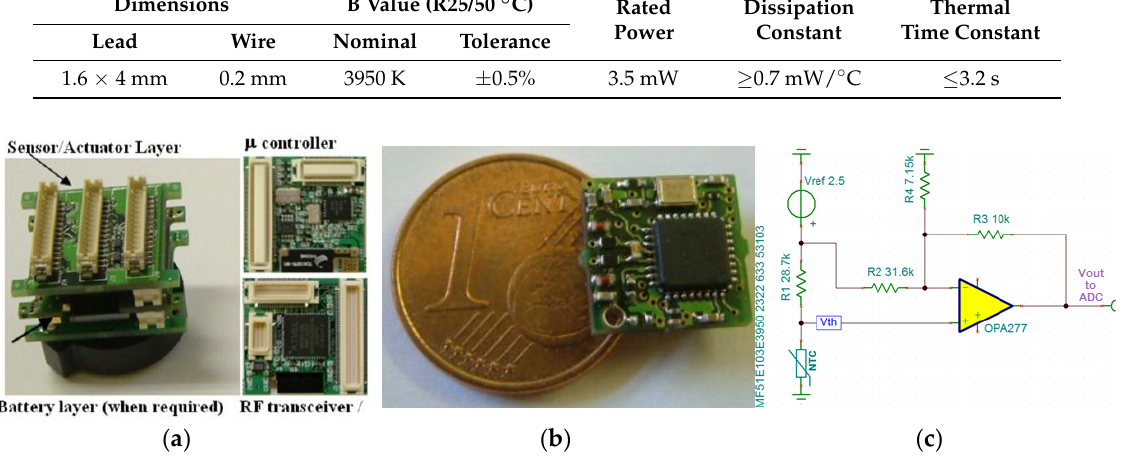
Figure 1. ( a ) Tyndall25 mote platform; ( b ) Tyndall10 mote; ( c ) thermistor interfacing circuit to the analog-to-digital converter (ADC). Table 3. Temperature values mapped to ADC values and related circuit